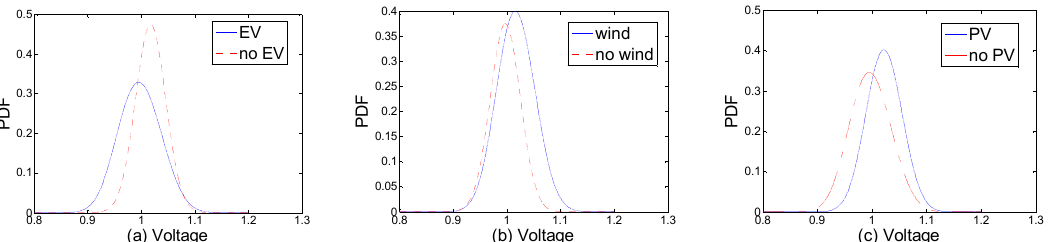
Figure 4. Probability distribution of node voltage; ( a ) EV ( b ) Distributed wind power ( c ) Distributed solar PV.